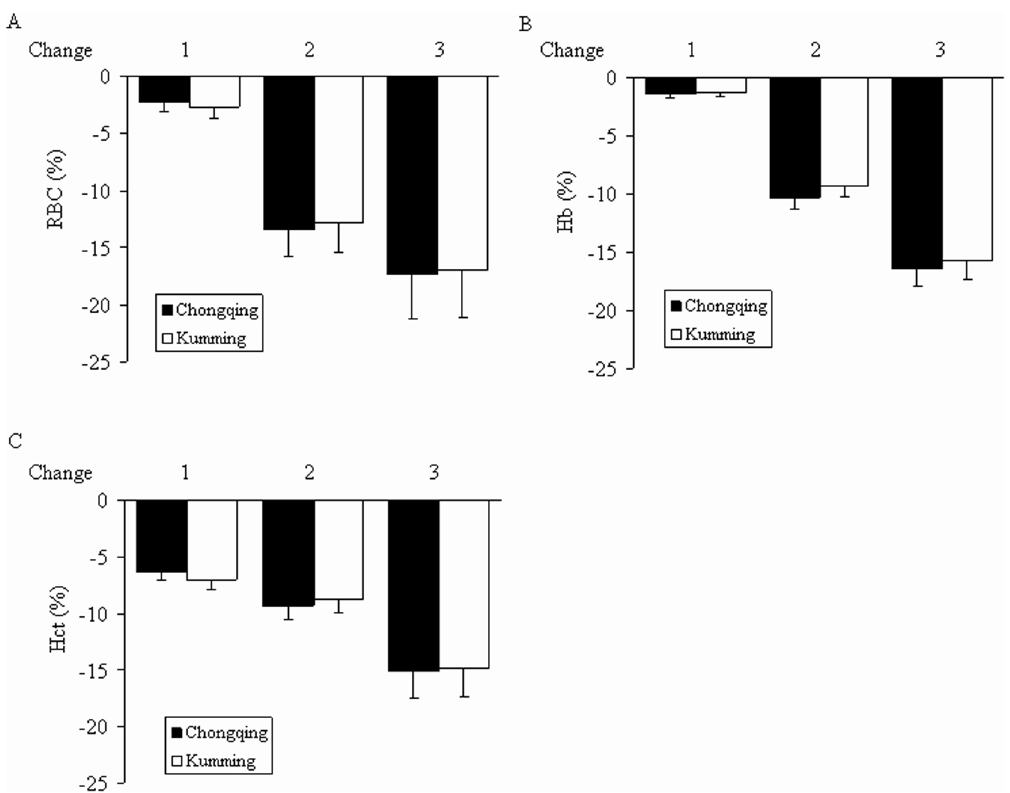
Figure 3. Rates of change of RBC, Hb, and Hct. Data are presented as mean 6 SD. The rate of change of (A) RBC, (B) Hb, and (C) Hct. Values recorded in subjects at high altitudes served as a baseline. Rate of change 1=(value on the 3rd day-value at high altitudes)/value at high altitudes 6 100%; rate of change 2=(value on the 50th day-value at high altitudes)/value at high altitudes 6 100%, rate of change 3=(value on the 100th day-value at high altitudes)/value at high altitudes 6 100%. Rates of change 1, 2, and 3 showed no significant differences between the Chongqing and Kunming groups ( P . 0.05).